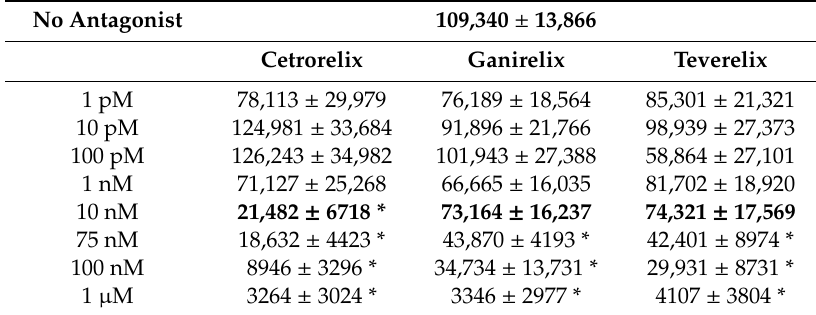
Table 1. GnRH-antagonist dose-dependent AUCs of the kinetics of intracellular Ca 2 + response. No Antagonist 109,340 ± 13,866 Cetrorelix Ganirelix Teverelix 1 pM 78,113 ± 29,979 76,189 ± 18,564 85,301 ± 21,321 10 pM 124,981 ± 33,684 91,896 ± 21,766 98,939 ± 27,373 100 pM 126,243 ± 34,982 101,943 ± 27,388 58,864 ± 27,101 1 nM 71,127 ± 25,268 66,665 ± 16,035 81,702 ± 18,920 10 nM 21,482 ± 6718 * 73,164 ± 16,237 74,321 ± 17,569 75 nM 18,632 ± 4423 * 8946 ± 3296 * 34,734 ± 13,731 * 29,931 ± 8731 * 1 µ M 3264 ± 3024 * 3346 ± 2977 * 4107 ± 3804